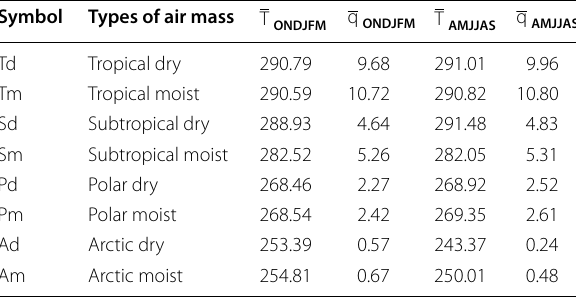
Table 2 Characteristics of each dry and moist air mass